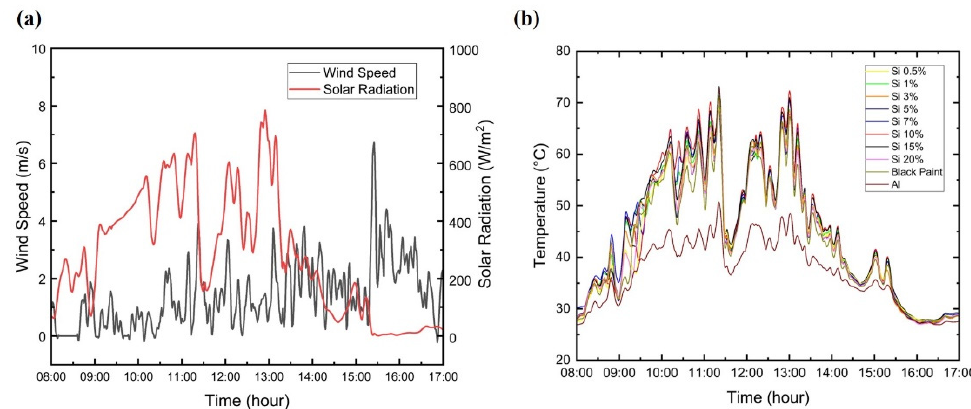
Figure 7. Outdoor experiment data at 27 September 2020: ( a ) weather profile, and ( b ) temperature of the absorber plates. Table 3. Summary of the maximum observed temperature on the absorber surface vs. the concen- tration of silicon in black paint.